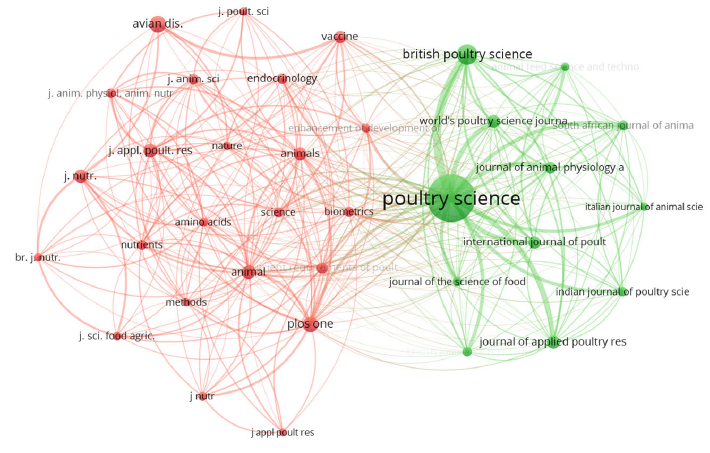
Figure 11. Journal co-citation network.